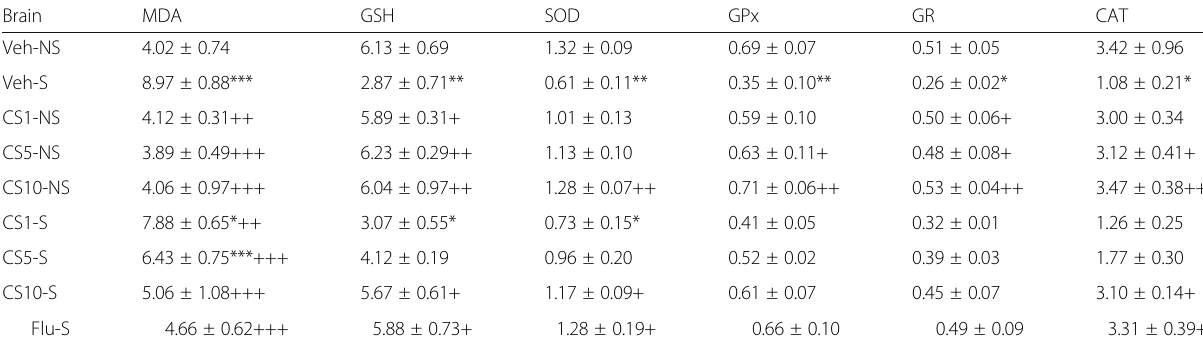
Table 1 Effect of CS and Flu (positive control) on the MDA (nmol/mgp), GSH ( μ mol/mgp), SOD (U/mgp), GPx (U/mgp), GR (U/mgp), and CAT (U/mgp) levels in brain of immobilization stress and control groups ( n = 8, for each group)